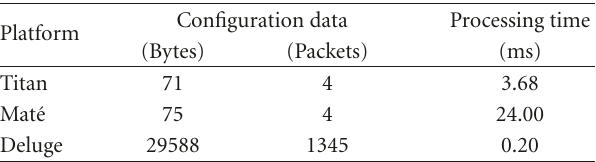
Table 5: Characteristics of a simple configuration for sampling, feature processing, and sending for di ff erent